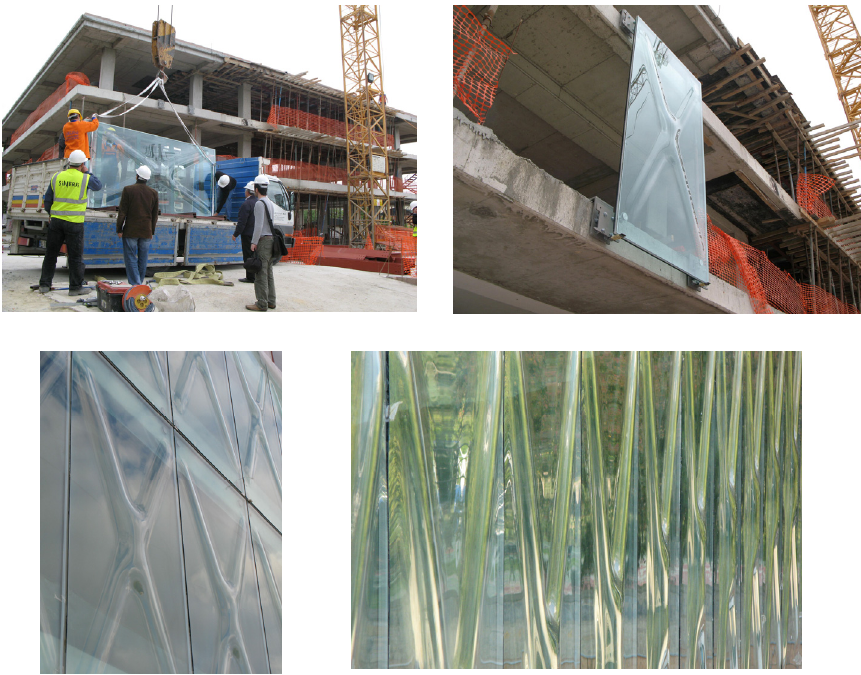
Figure 16a, b, c, d: First Panel Delivery, Install, Detail View, Oblique